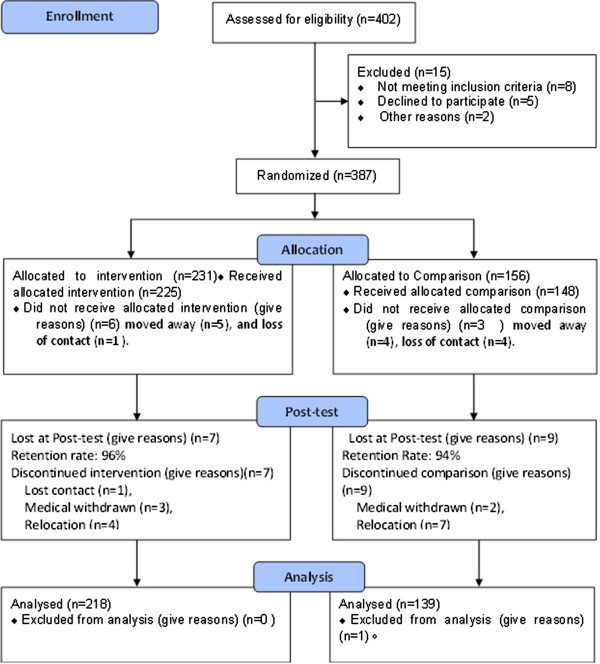
Study participant flow diagram.